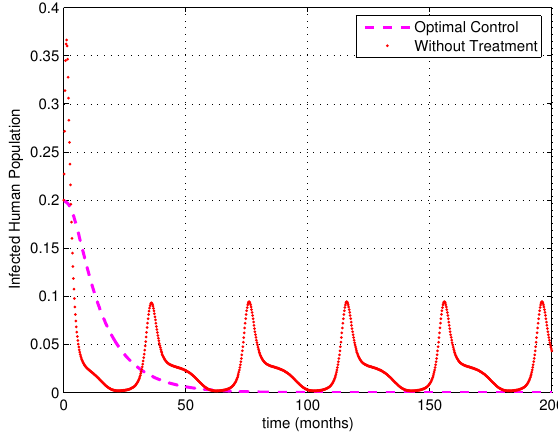
Figure 1. Simulation results showing the infected